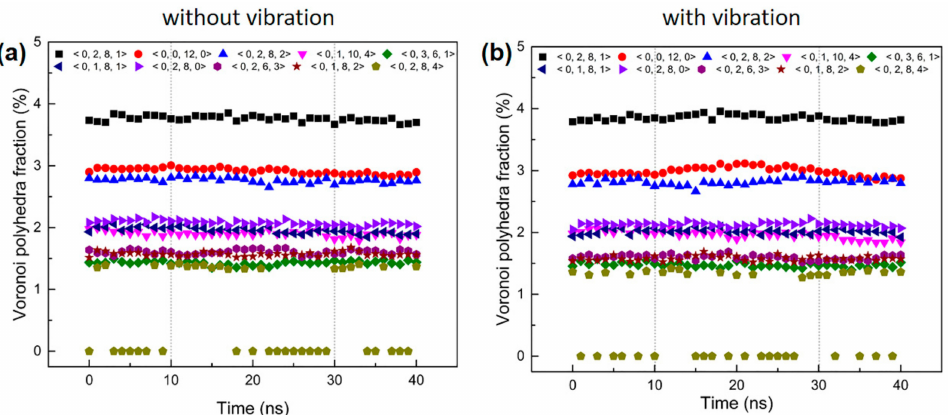
Figure 6. The evolution of Voronoi polyhedra contents during tension, ( a ) without vibrational loading and ( b ) with vibrational loading.